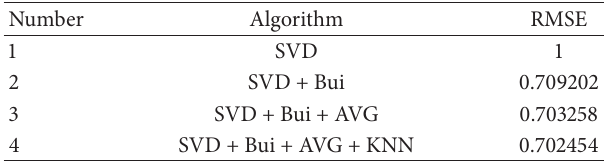
Table 1: RMSE comparison of different